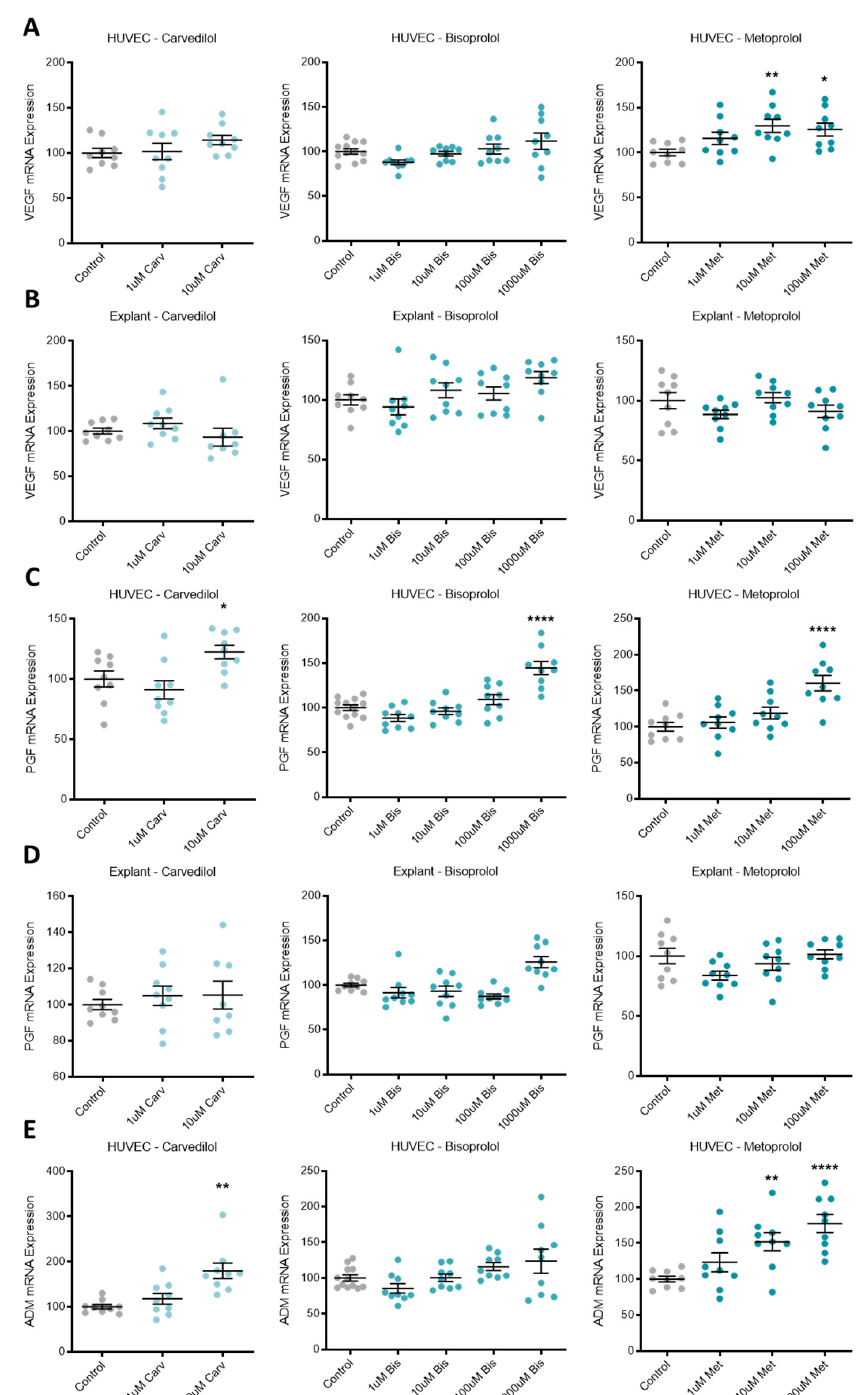
Figure 3. Pro-angiogenic factors upregulated following beta-blocker treatment of HUVECs, but not explants. VEGF mRNA expression in HUVECs ( A ) was significantly increased with metoprolol (Met) treatment, but not carvedilol (Carv) or bisoprolol (Bis). PGF mRNA expression in HUVECs ( C ) was significantly increased with the top dose of Carv, Bis, and Met. ADM mRNA expression in HUVECs ( E ) was significantly increased with top dose Carv treatment and Met treatment, but not Bis. VEGF and PGF mRNA expression were unchanged in placental explants following beta-blocker treatment ( B , D , respectively). Data are mean ± SEM, expressed as a percentage of control, n = 3–4, * p < 0.05, ** p < 0.01, **** p < 0.0001.